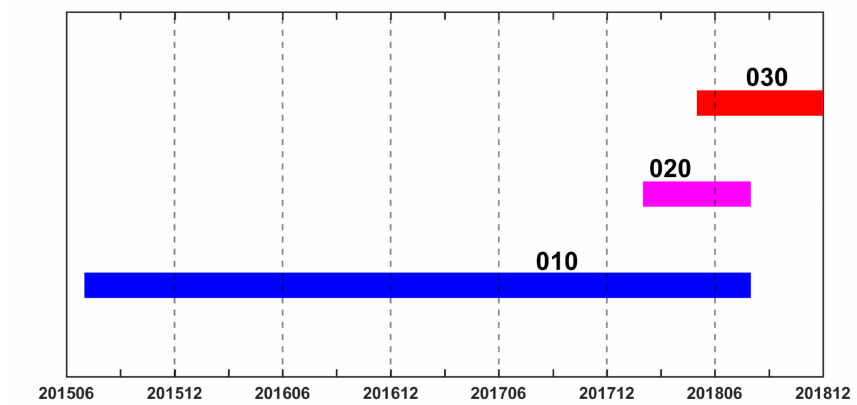
Figure 1. The coverage periods for the three versions validated here. The blue line stands for version 010 since the launch of Himawari-8 / Advanced Himawari Imager (H8 / AHI). Versions 020 and 030 (violet and red lines) were subsequently released in